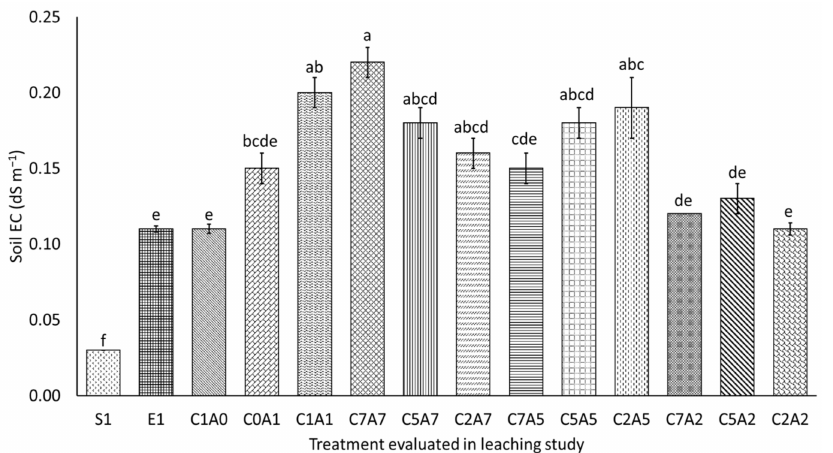
Figure 10. Treatments on soil electrical conductivity after thirty days of leaching, where S1: soil only; E1: soil with ERP only; C1: 100% charcoal; C0: 0% charcoal; C7: 75% charcoal; C5: 50% charcoal; C2: 25% charcoal; A1: 100% sago bark ash; A0: 0% sago bark ash; A7: 75% sago bark ash; A5: 50% sago bark ash; A2: 25% sago bark ash. Means with different letter(s) indicate significant differences between treatments according to Tukey’s HSD test at p ≤ 0.05, that is, a > b > c. Bars represent the mean values ±